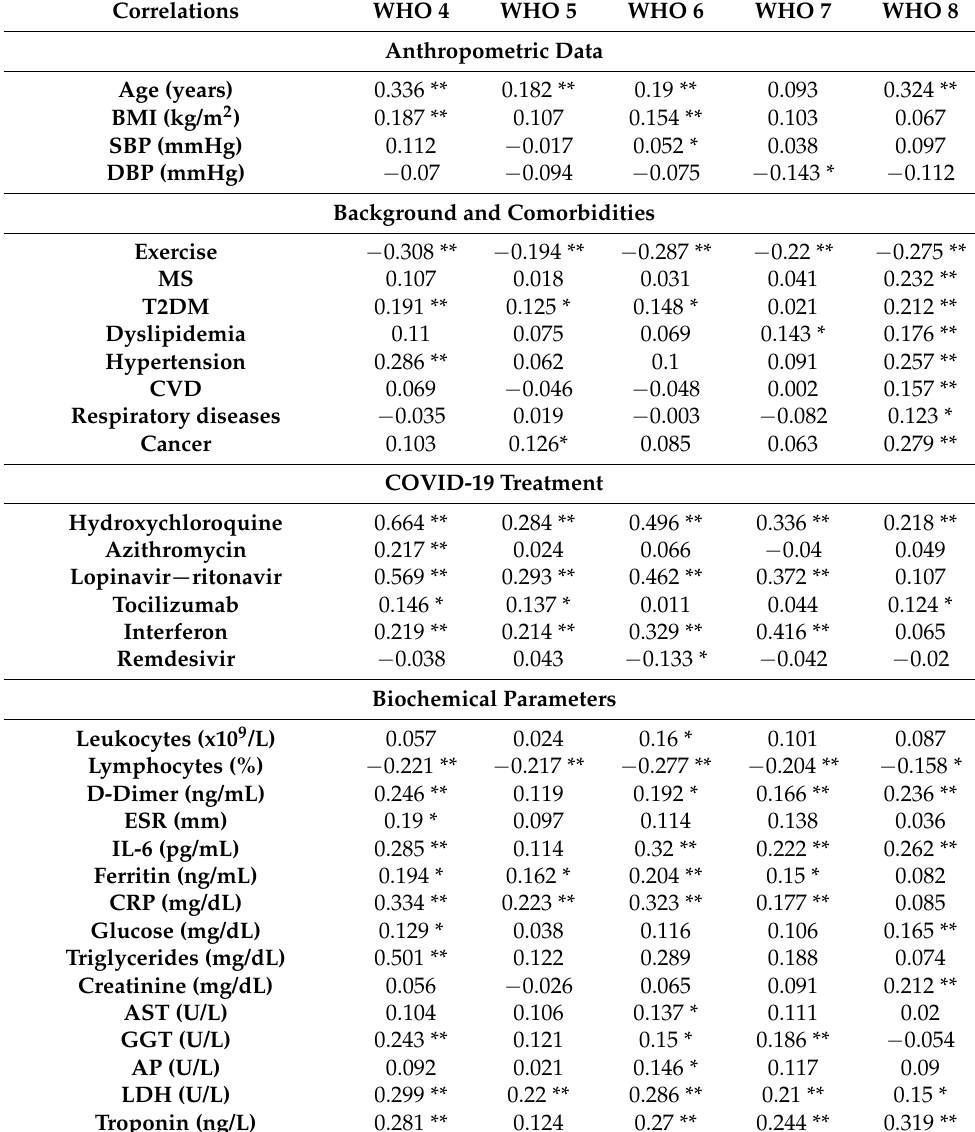
Table 3. Significant associations between different variables of COVID-19 patients (anthropometric data, background, treatment, and biochemical variables) and WHO eight-point classification of severe pneumonia by COVID-19